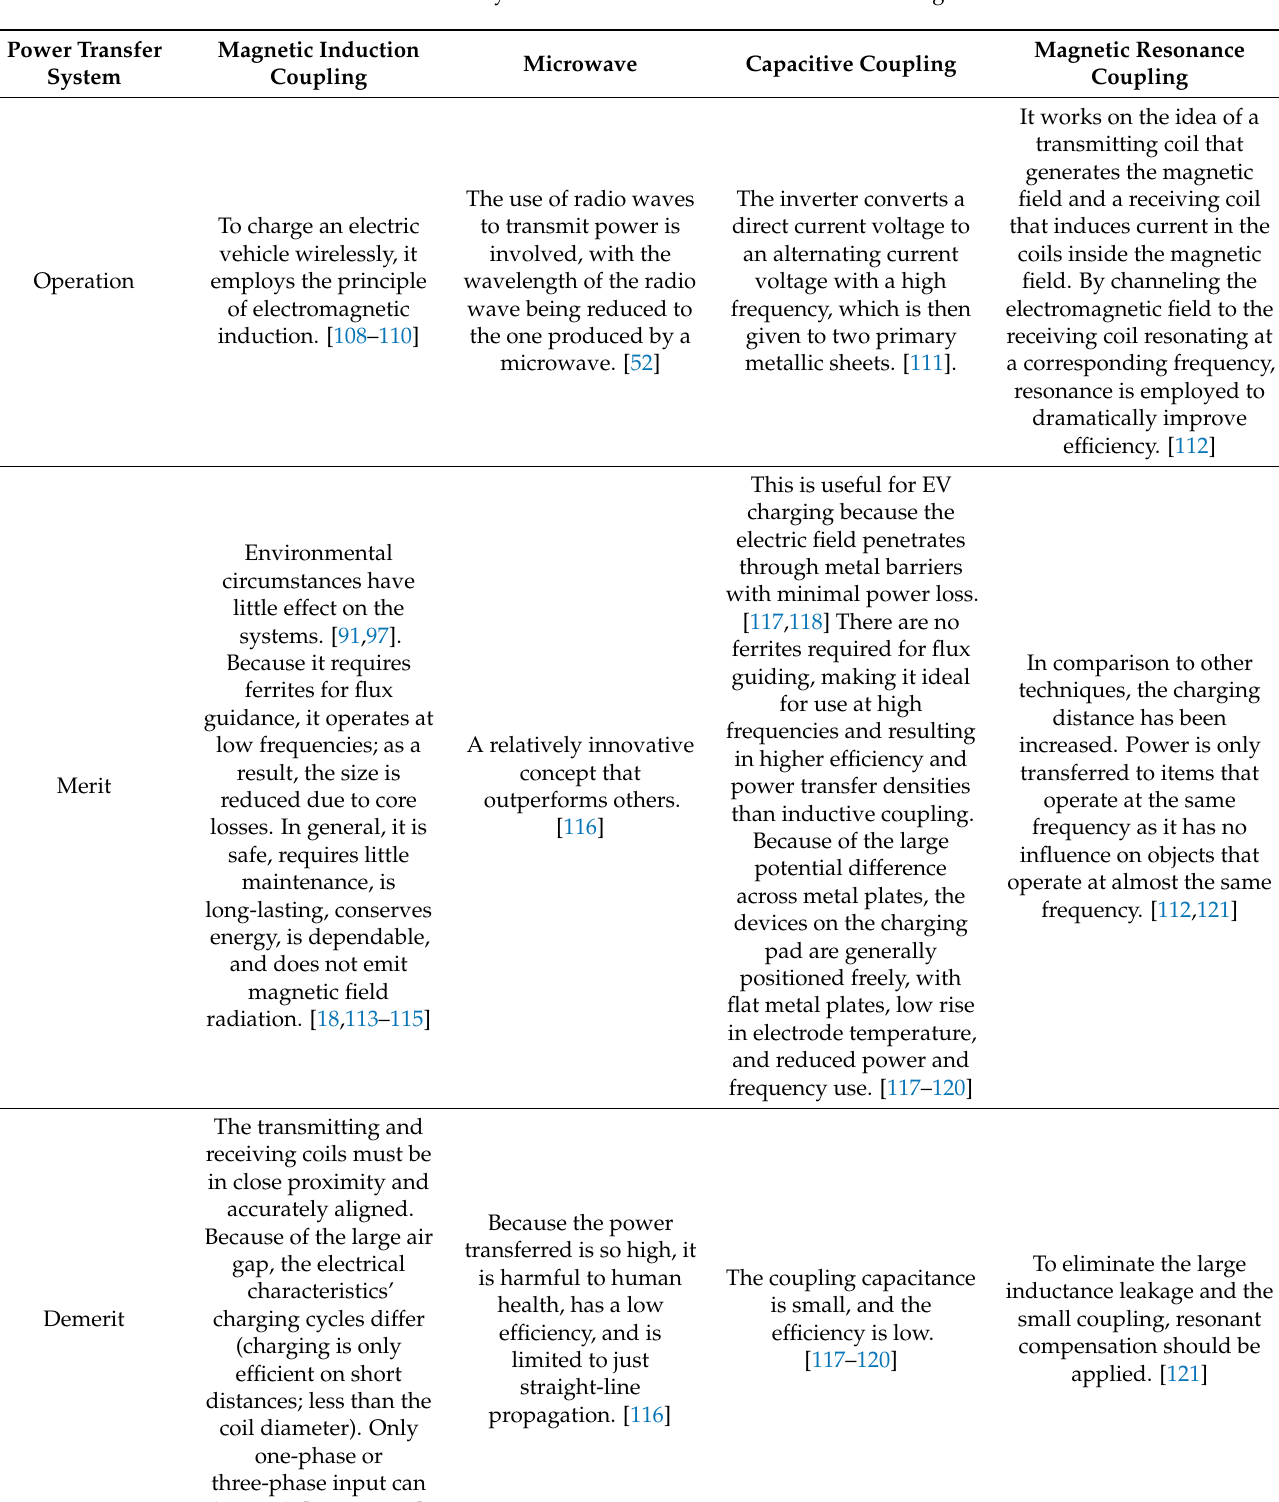
Table A1. Summary of Some Wireless Power Transfer